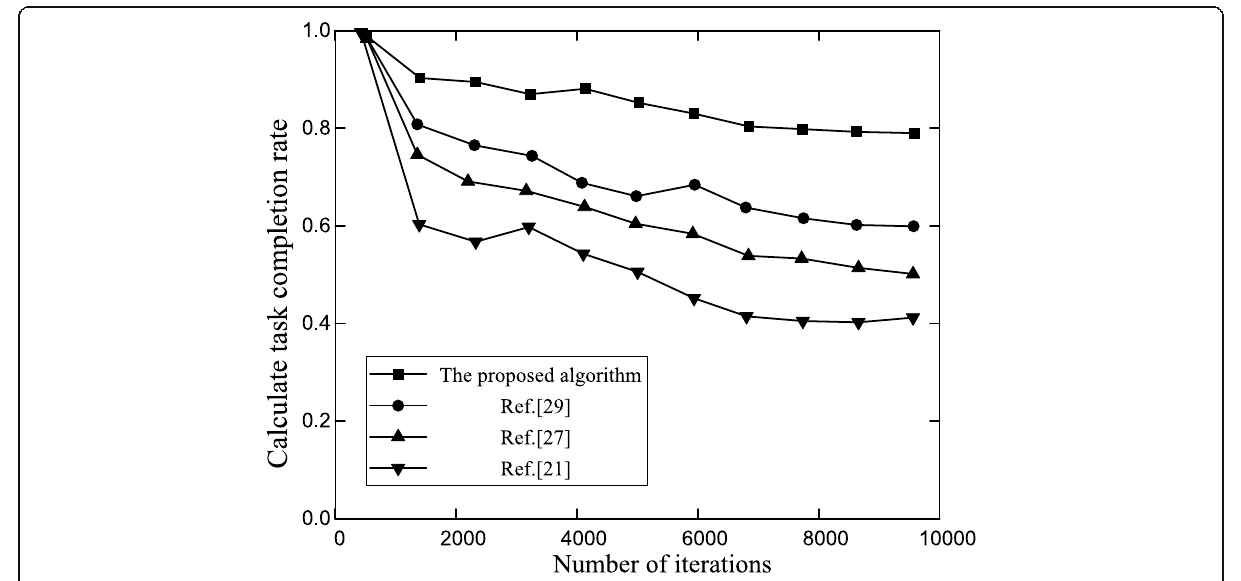
Fig. 10 Comparison of task completion rate of different algorithms